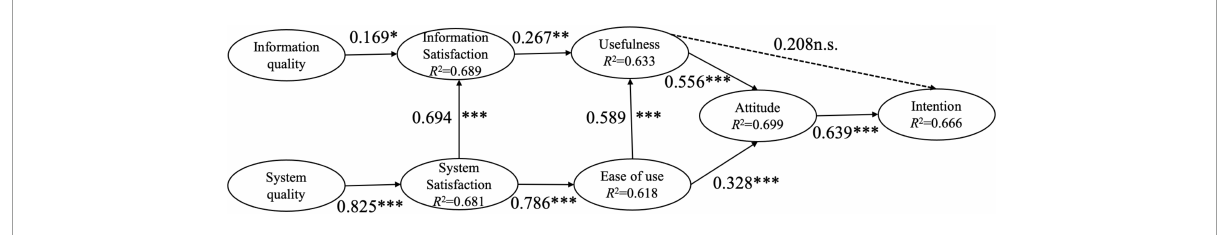
FIGURE1 Structural model for the group of blended learning. ∗ p < 0.05; ∗∗ p < 0.01; ∗∗∗ p < 0.001; n.s. =